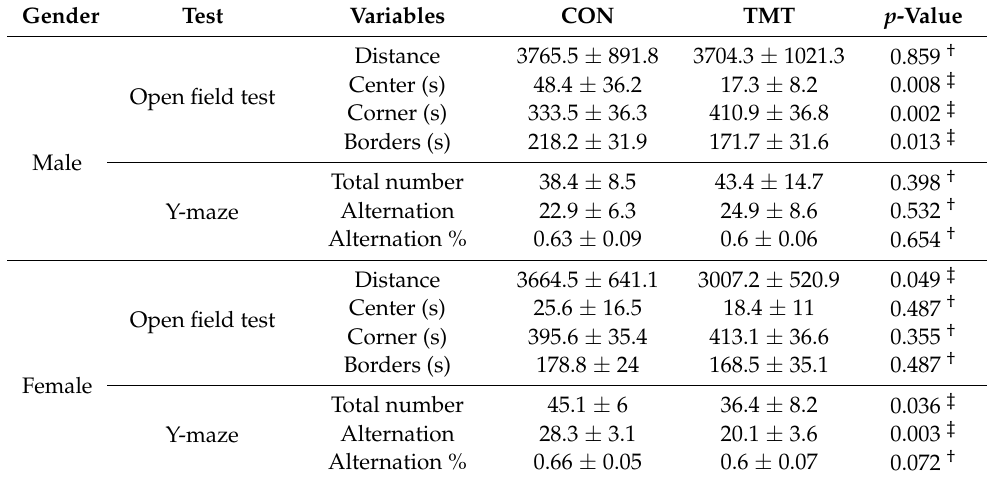
Table 1. Behavior test results of 5 week-old mice shows sex differences in prenatal TMT treatment.